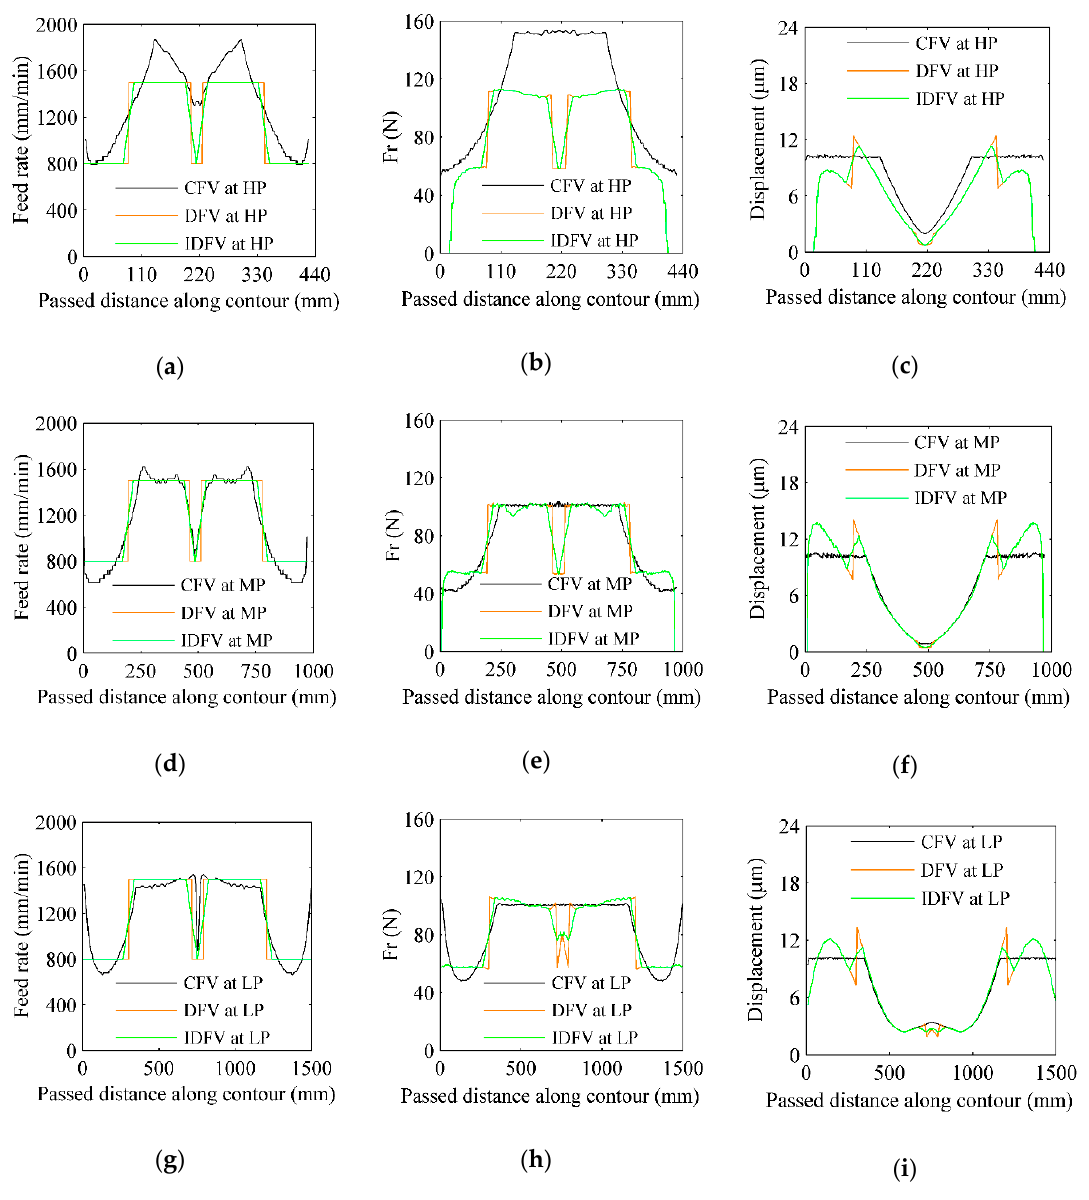
Figure 13. Results of continuous feed rate variation (CFV), discrete feed rate variation (DFV) and improved discrete feed rate variation (IDFV) for each single contour: ( a , d , g ) feed rate; ( b , e , h ) radial cutting force; ( c , f , i ) vibration response; ( a – c ) contour at HP; ( d – f ) contour at MP; ( g – i ) contour at LP.